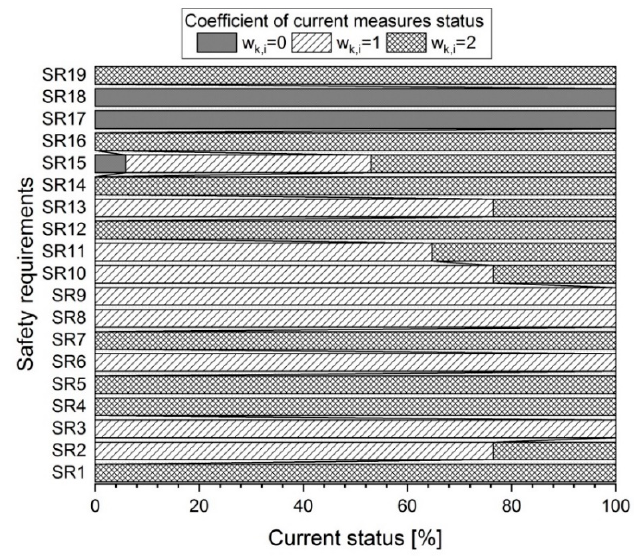
Figure 3. Evaluations of the safety measures status on machines in operation I in [%] (source: own design).